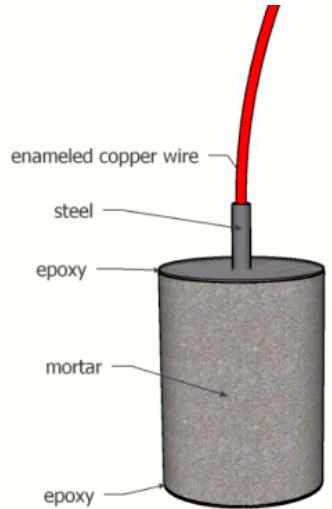
Figure 1. Rebar-embedded cement mortar specimen.